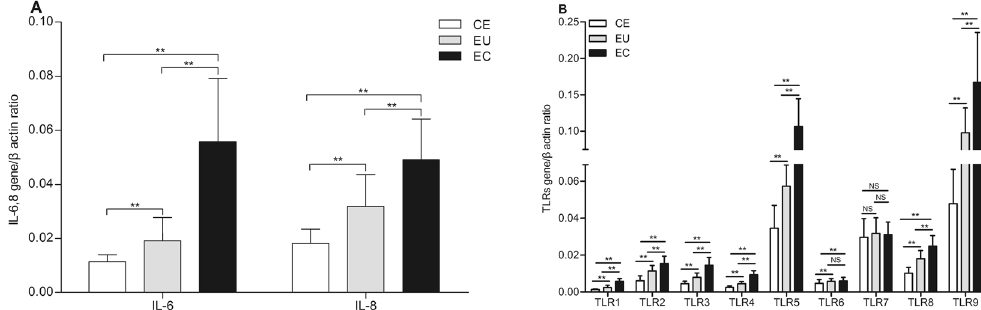
Figure 1. mRNAs expression of IL-6, IL-8 and TLRs in CE, EU and EC. CE: endometrium without adenomyosis; EU: eutopic endometrium with adenomyosis; EC: ectopic endometrium with adenomyosis; NS P > 0.05; * P < 0.05; ** P < 0.01.